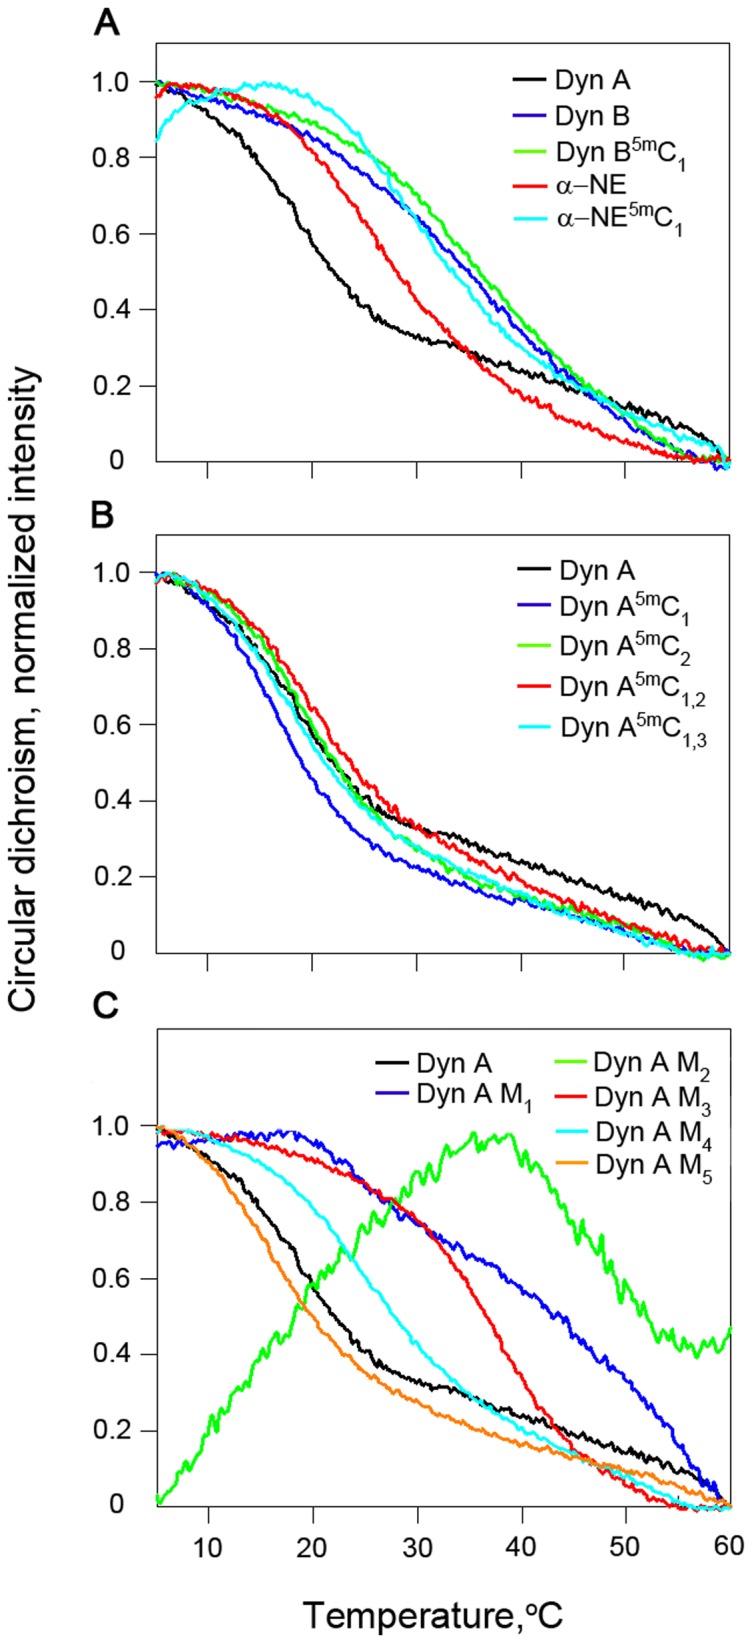
Normalized thermal melting profiles of PDYN-derived oligonucleotides recorded with CD spectroscopy (275 nm) between 5°C and 60°C.Normalization was performed using the formula, (St−S60°C)/(S5°C−S60°C), where St, S5°C and S60°C are the signal intensities at 275 nm at a given temperature, 5°C, and 60°C, respectively. A. Black – Dyn A; Blue – Dyn B; Green – Dyn B5mC1; Red – α-NE; Turquoise – α-NE5mC1. B. Black – Dyn A; Blue – Dyn A5mC1; Green – Dyn A5mC2; Red – Dyn A5mC1,2; Turquoise – Dyn A5mC1,3. C. Black – Dyn A; Blue – Dyn A M1; Green – Dyn A M2; Red – Dyn A M3; Turquoise – Dyn A M4; Orange - Dyn A M5.